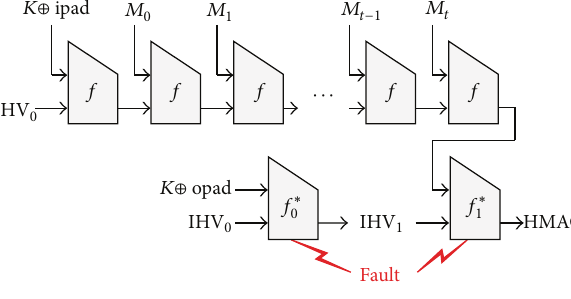
Figure 1: Our fault model on